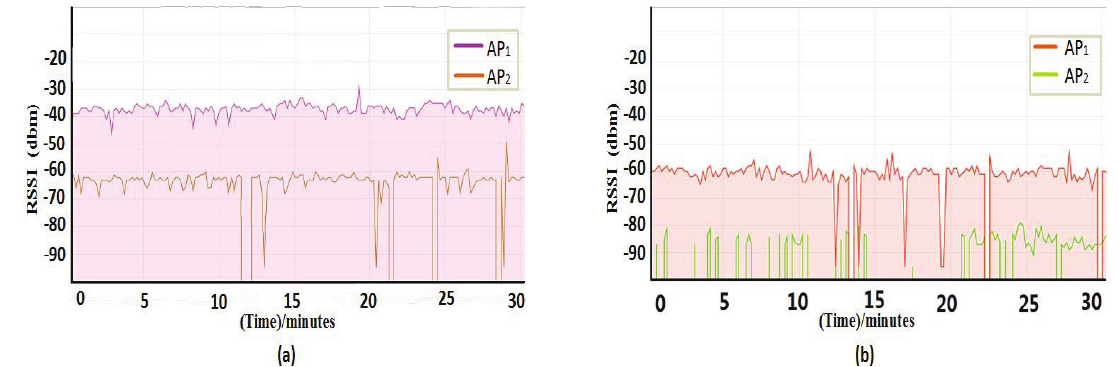
Figure 3. Signal strength analysis. ( a ) Description of RSSI at 2 m away from the AP. ( b ) Description of RSSI at 6 m away from the